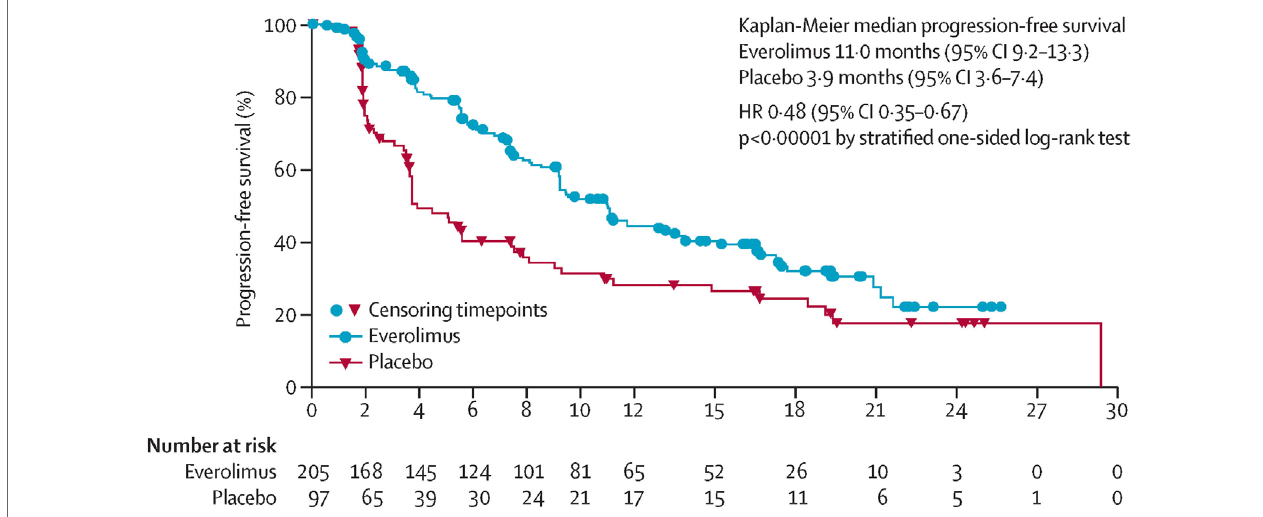
FiGURe 2 | Progression-free survival curve from Radiant 4 trial. PFS curve from the RADIANT 4 trial. Reprinted from Yao et al. (36), Copyright 2016, with permission from